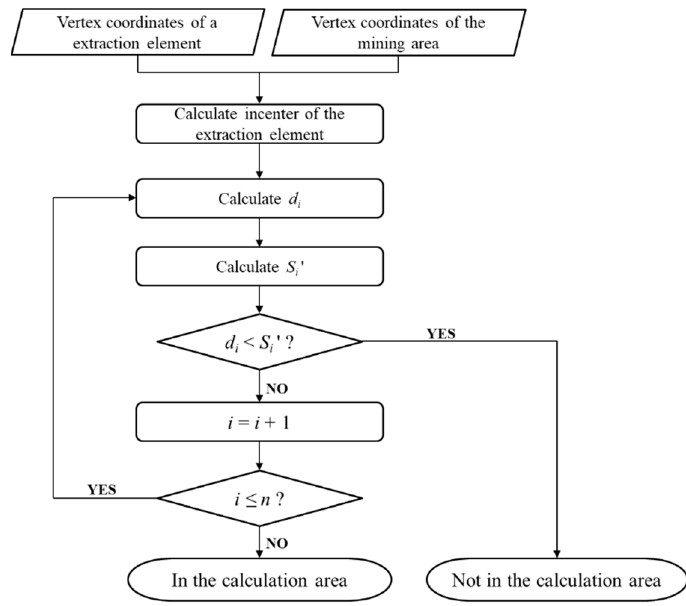
Figure 6. Flowchart of determination of an extraction element within the calculation area.